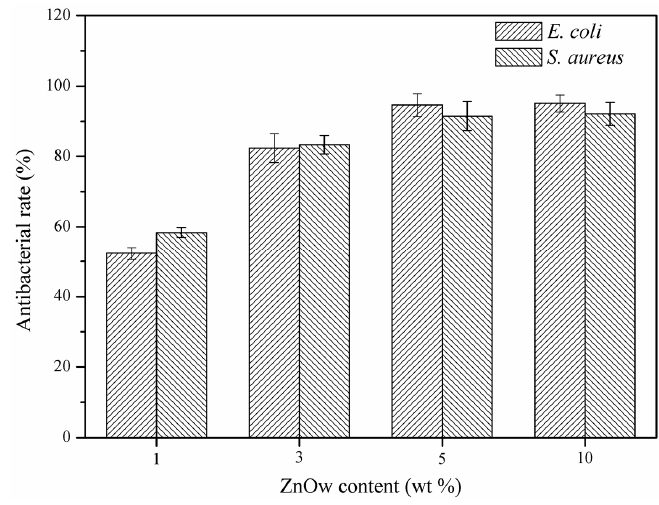
Figure 2. Antibacterial rate for the scaffolds with different contents of ZnOw.